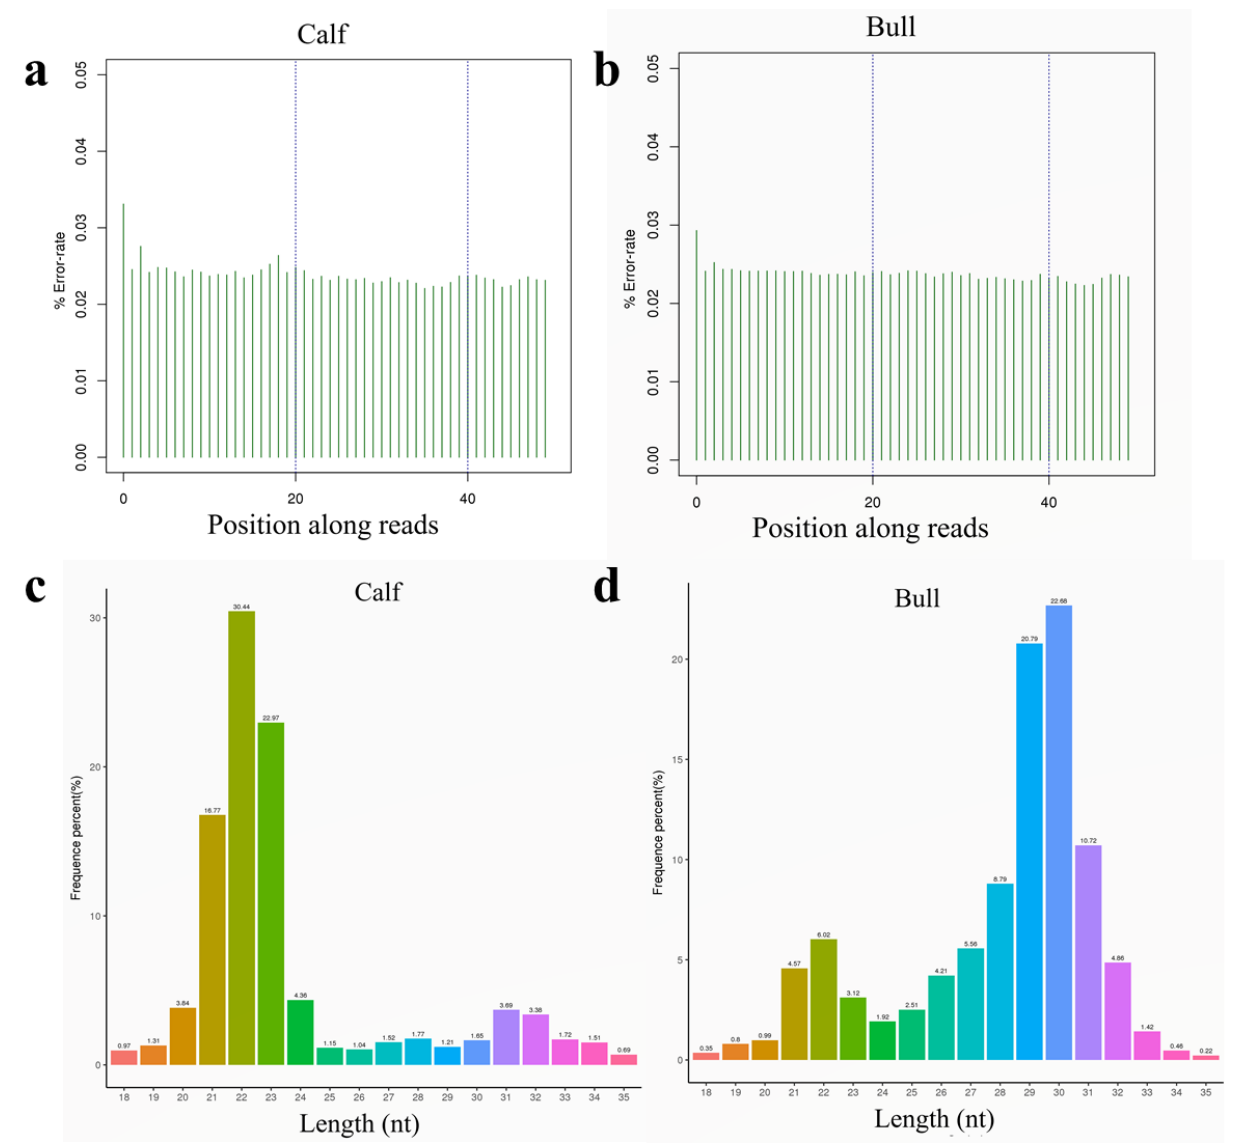
Figure 2. The % error rate and sRNAs length screening was shown in testicular tissue. ( a ) The abscissa represents the base position of reads, and the ordinate shows the error rate of a single base in calf. ( b ) Sequencing error rate distribution in the mature bull. ( c ) The abscissa showed the length of reads, and the ordinate is the proportion of reads in the calf. ( d ) Total s-RNA fragment length distribution statistics in the mature